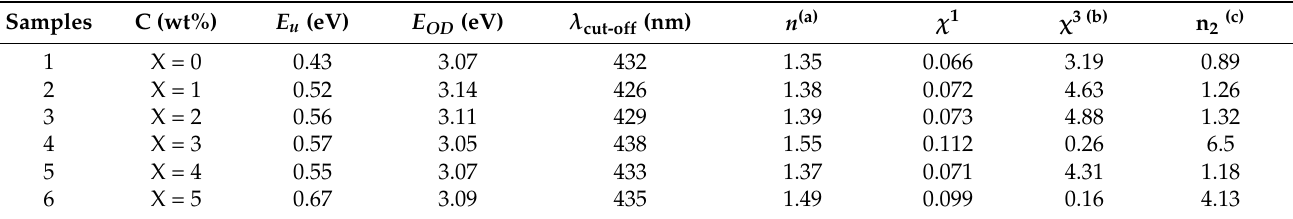
Figure 4. The dependence of ( α h ν ) 2 on the photon energy ( h ν ) for the prepared glass samples. Table 2. Concentration ( C ), Urbach energy ( E u ), energy gap indirect ( E OIn ), energy gap direct ( E OD ), prepared glass